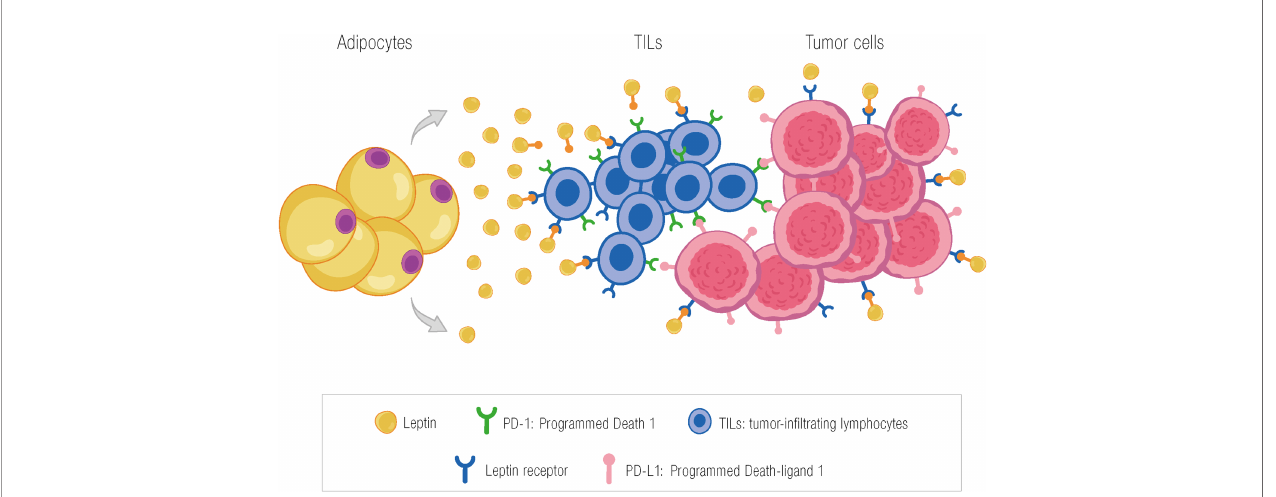
FIGURE 2 | Potential effect of leptin in activating TILs in the tumor microenvironment through the leptin receptor. The presence of TILs in the tumor microenvironment may be due, among other factors, to the action of leptin through binding to its receptor on T cells. PD-1, programmed death 1; TILs, tumor- in fi ltrating lymphocytes; PD-L1, programmed death-ligand 1; Garc ı ́ a-Este ́ vez L ©